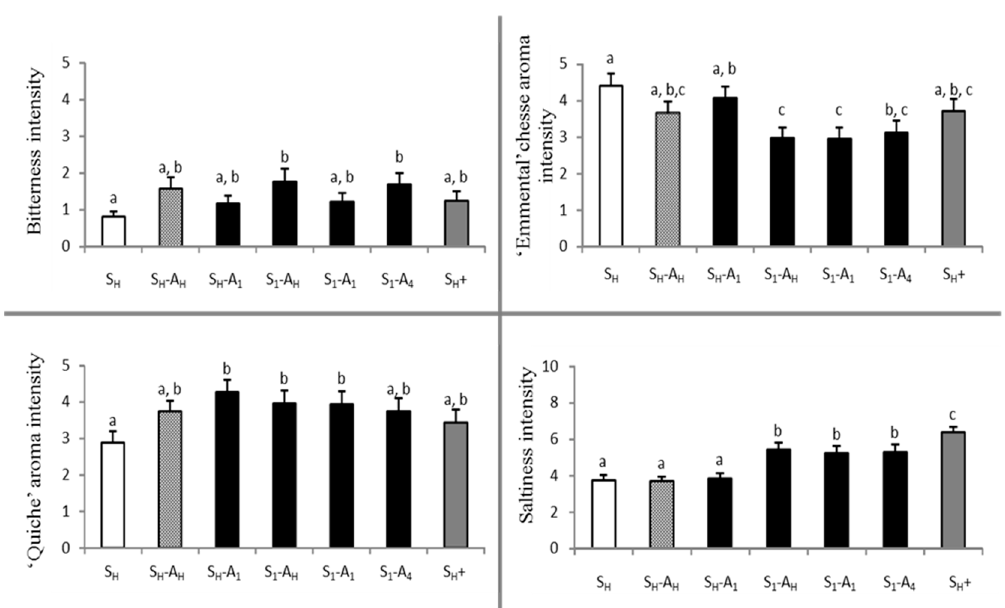
Figure 3. Mean intensity scores obtained for bitter, “Emmental” cheese aroma, “quiche” aroma, and salt attributes by descriptive analysis. Error bars represent the standard error of the mean. Identical letters indicate that odour intensity means are not significantly different at a level of 5% (Student–Newman–Keuls (SNK) test). S H and A H : homogeneous distribution of salt and aroma, respectively. S n and A n : heterogeneous distribution of salt and aroma in layer n, respectively. S H +: contains 35% more salt than S H .